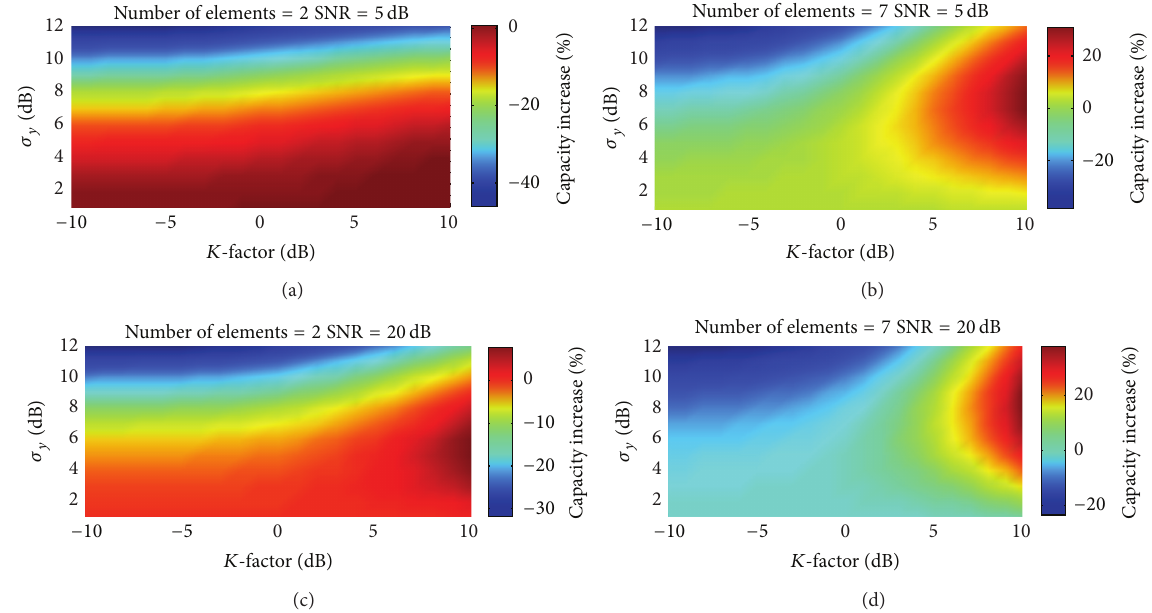
Figure 13: Capacity increase (%) versus the 𝐾 -factor and versus shadowing, (a) with SNR = 5 dB and number of elements equal to 2, (b) SNR = 5 dB and 7 elements, (c) SNR = 20 dB and 2 elements, and (d) SNR = 20 dB and 7